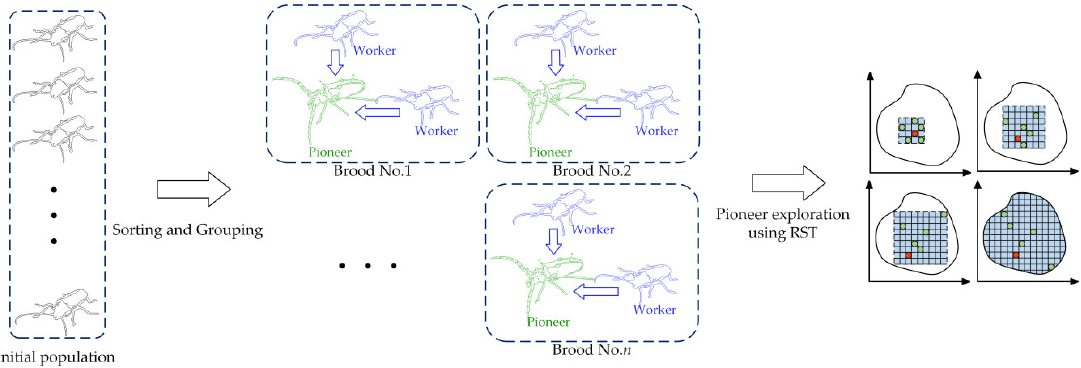
Figure 4. Illustration of the improved deterministic area search.